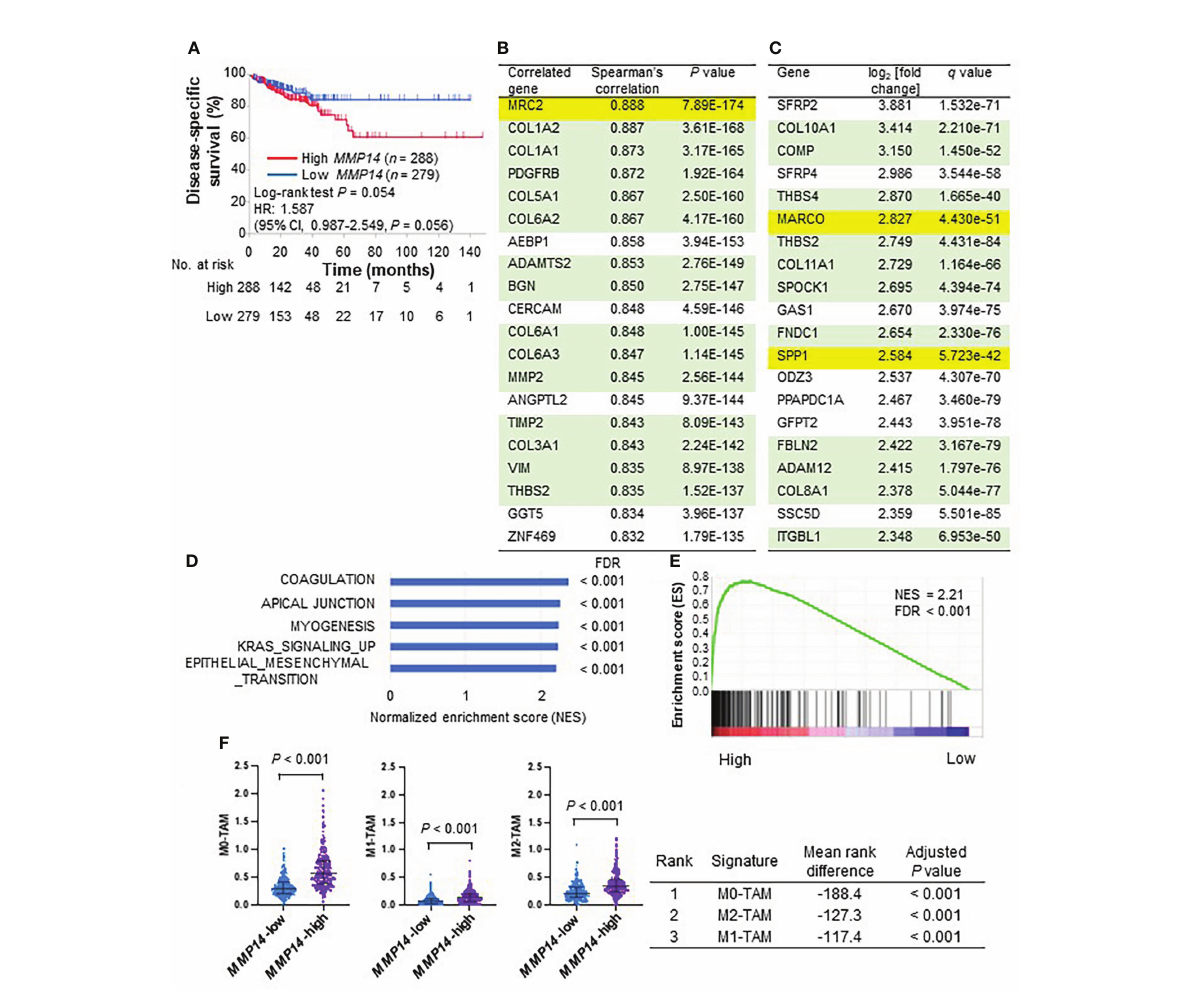
FIGURE 1 Analysis of the colorectal adenocarcinoma cohort ( n = 592) of the TCGA database according to MMP14 expression. (A) Kaplan-Meier curves for disease-speci fi c survival in patients divided according to the median value of MMP14 expression level. Vertical bars denote censoring. (B) The top 20 genes whose expression level was correlated with that of MMP14 ranked according to Spearman ’ s correlation coef fi cient. Genes related to stromal tissue or M2-TAMs are highlighted in green and yellow, respectively. (C) The top 20 genes whose expression was associated with that of MMP14 ranked according to log 2 of the fold change in normalized expression value for MMP14 -high relative to MMP14 -low tumors. FDR q values were also calculated. Genes are highlighted as in (B) . (D) The top fi ve hallmark gene sets whose expression was up-regulated in the MMP14 -high group as revealed by GSEA. FDR q values were calculated with GSEA software. (E) GSEA plot of enrichment for the gene signature related to epithelial-mesenchymal transition for MMP14 -high versus MMP14 -low tumors. (F) The top three immune cell signatures associated with MMP14 expression by CIBERSORTx analysis. In the dot plots for the immune cell signatures (top), each dot represents one patient and the median value and interquartile range are indicated. The mean rank difference values and adjusted P values calculated by multiple Wilcoxon rank-sum tests with Bonferroni correction are also shown